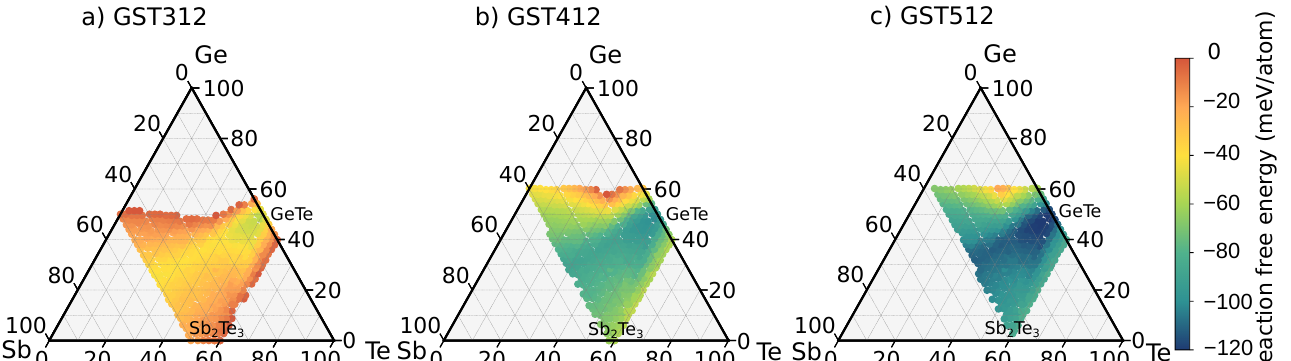
Figure 3. Maps of the decomposition pathways during crystallization of ( a ) GST312, ( b ) GST412, and ( c ) GST512. The color code gives the reaction free energy (meV/atom) to form the cubic alloys on the ternary phase diagram starting from the reactant, i.e., GST312 in panel ( a ) (see